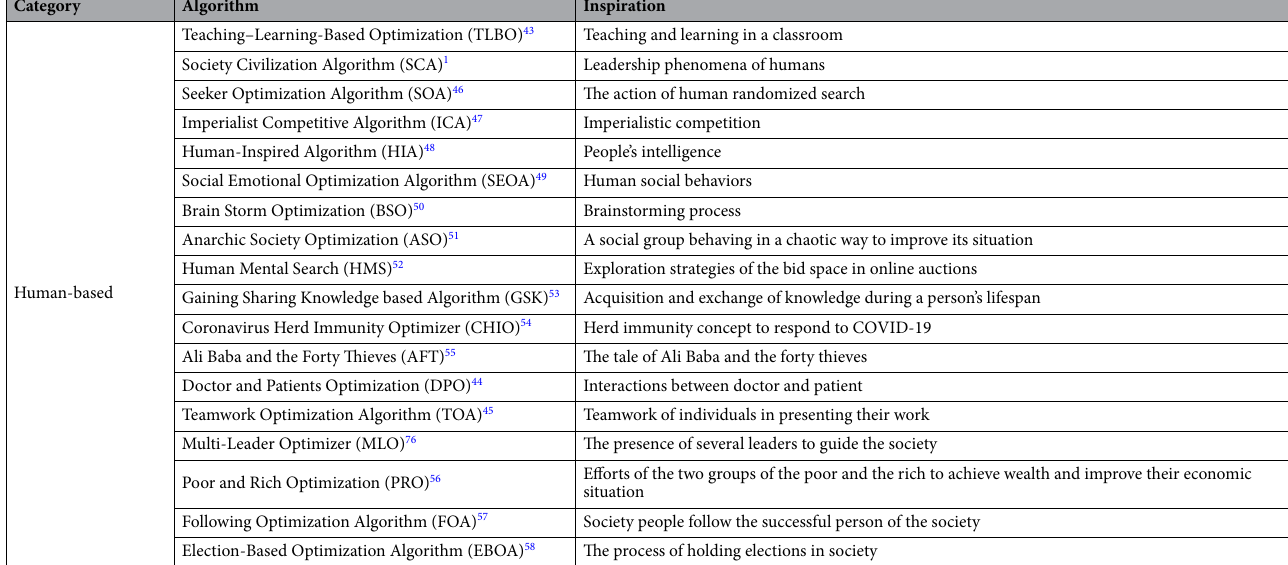
Table 1. A brief review of metaheuristic